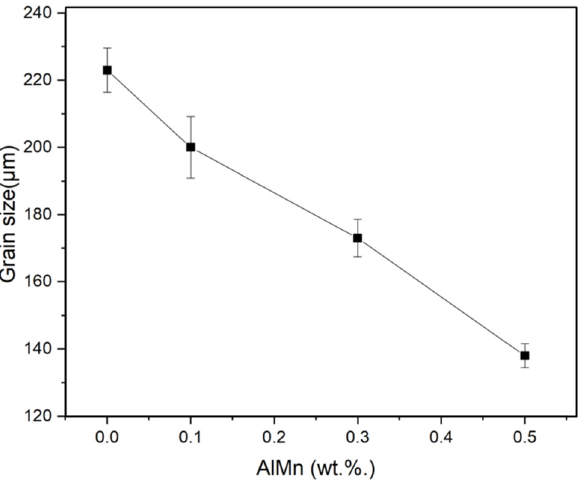
Figure 10. Grain size of the CP AZ91 Mg alloy with 0.1 wt.% to 0.5 wt.% Al-Mn master alloy ribbons.